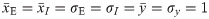
Input/Output time constants and learning performance.A: Variance of synaptic weights (fE = 1) for a linear perceptron of dimension N = 1000 trained on rbf-correlated signals with increasing time constant τ for three different values of the load α. Parameters: γ = 0.1, x¯E=x¯I=σE=σI=y¯=σy=1. B: Average error ϵerr in the case where input and output signals have two different covariance matrices, for increasing time constant τy of the output signal y. Parameters: N = 1000, fE = 0.8, γ = 0.1, x¯E=x¯I=y¯=σy=1, σI = 2σE = 0.6, Cx rbf with τx = 1, Cy rbf with various values of τy. Inset: norm of the weight vector w. Full lines show analytical results. Points are averages across 50 samples.